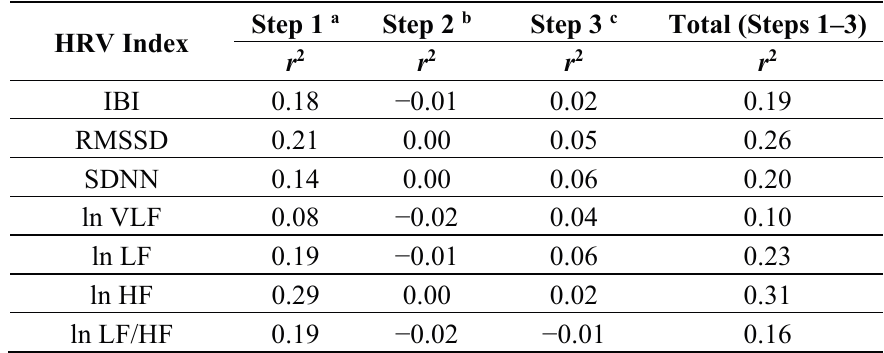
Table 4. Proportion of explained variance (adjusted r 2 change) in heart rate variability (HRV) indices for steps 1–3 in the hierarchical regression analyses comprising the primary adjusted model. Step 1 a Step 2 b Step 3 c Total (Steps 1–3) HRV Index r 2 r 2 IBI 0.18 − 0.01 0.02 0.19 RMSSD 0.21 0.00 0.05 SDNN 0.14